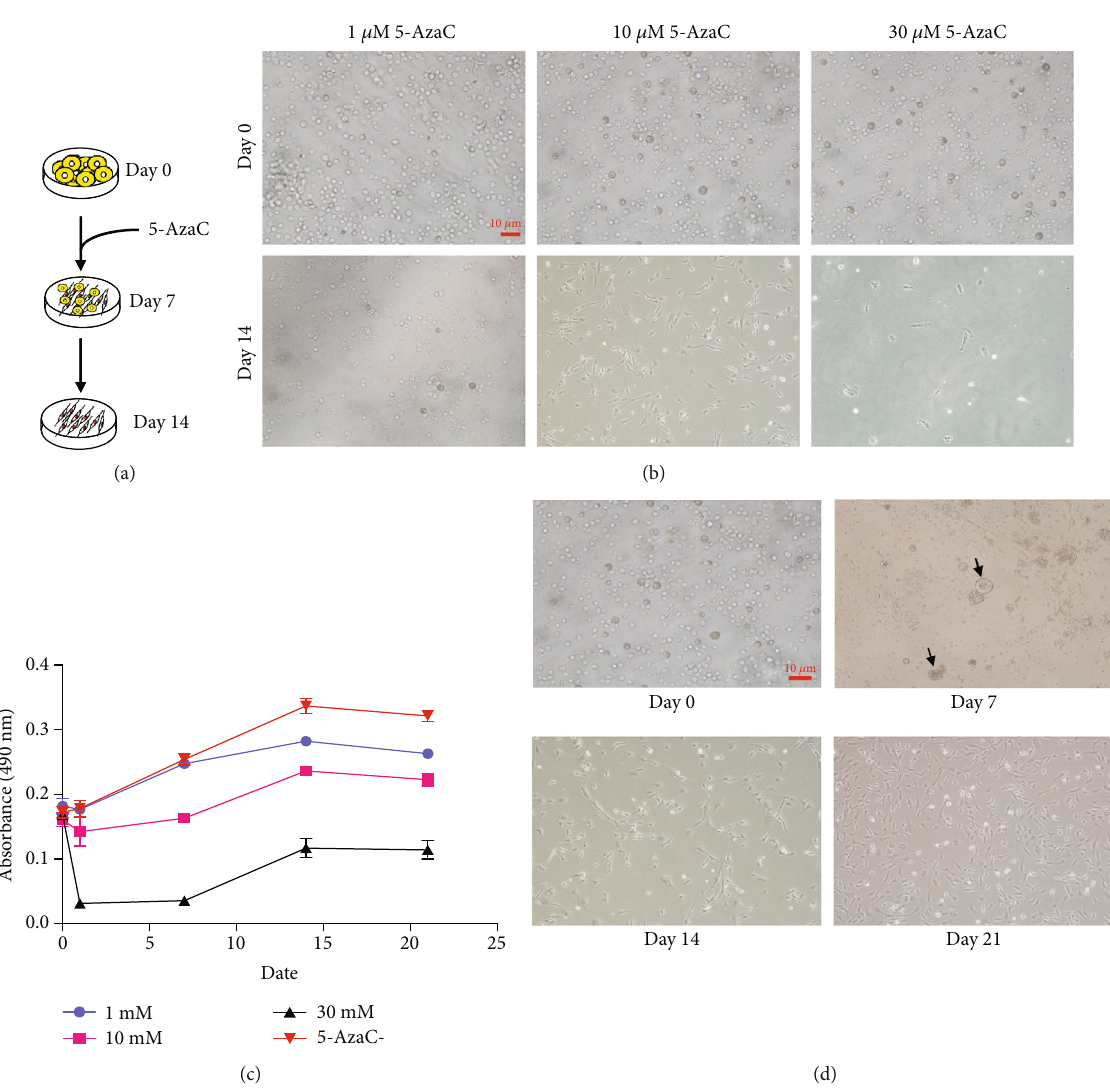
Figure 3: 5-AzaC induces cardiomyocyte-like morphology in BM-VSELs. (a) 5-AzaC-induced VSELs showed morphological changes at day 7, and the population of cardiomyocytes peaked at day 14. (b) Growth of VSELs treated with di ff erent concentrations of 5-AzaC (1 μ M, 10 μ M, and 30 μ M). (c) MTT assay indicated VSEL growth induced by di ff erent concentrations of 5-AzaC over time. (d) Morphological changes in BM-VSELs after treatment with 10 μ M 5-AzaC. The arrow indicates that VSELs developed embryoid body-like structures after 5-AzaC